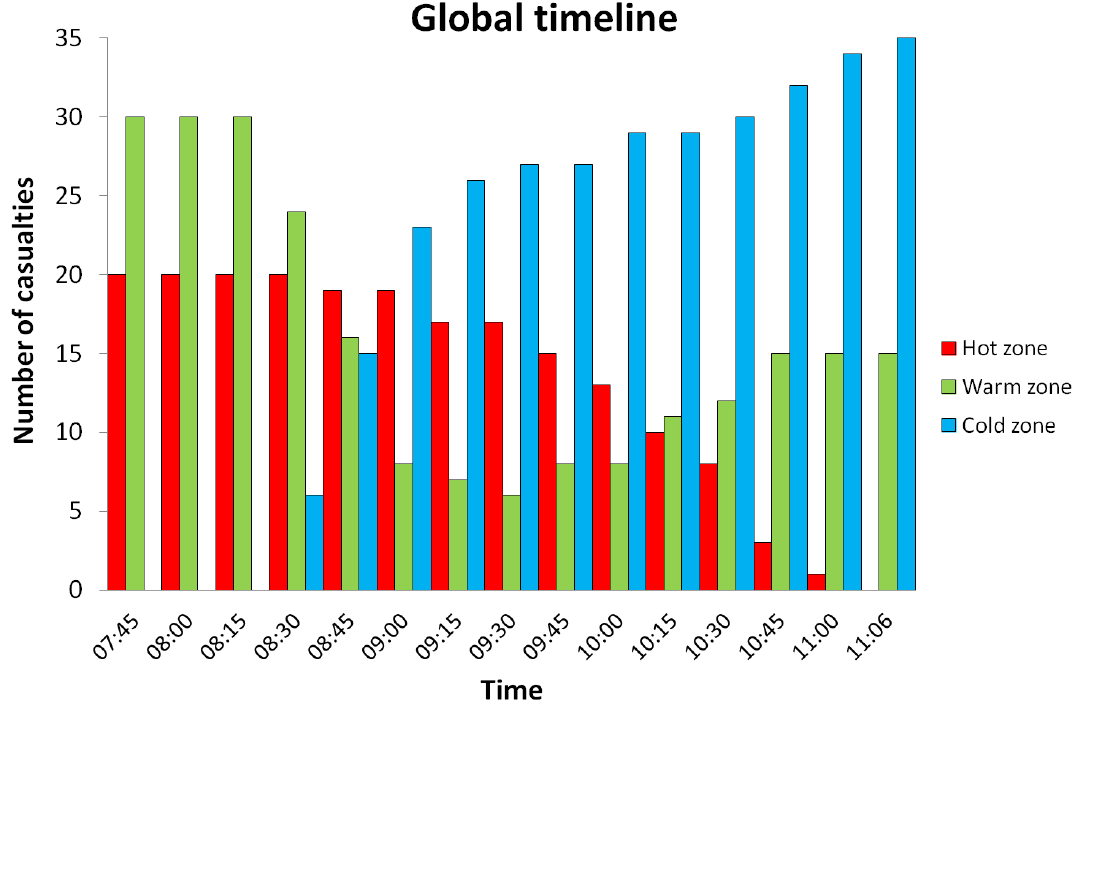
Figure A2. There were a total of 50 casualties (29 males, 21 females) in the system but due to the first 45 minutes ‗notional play‘ the exercise started with 20 casualties (12 males, 8 females) in the hot zone and 30 casualties (17 males, 13 females) in the warm zone. There was no casualty movement between the hot and warm zones or the warm and cold zones in the first 30 minutes of the exercise. The ―V‖ shape of the warm zone graph is a result of the flow of ambulant casualties through to the cold zone followed by the bottle- neck of non-ambulant casualties in the warm zone. At the end of the exercise (total duration 3 hours 21 minutes) all 20 casualties had been removed from the hot zone, 15 casualties (10 males, 5 females) were in the warm zone and 35 casualties (19 males, 16 females) were in the cold